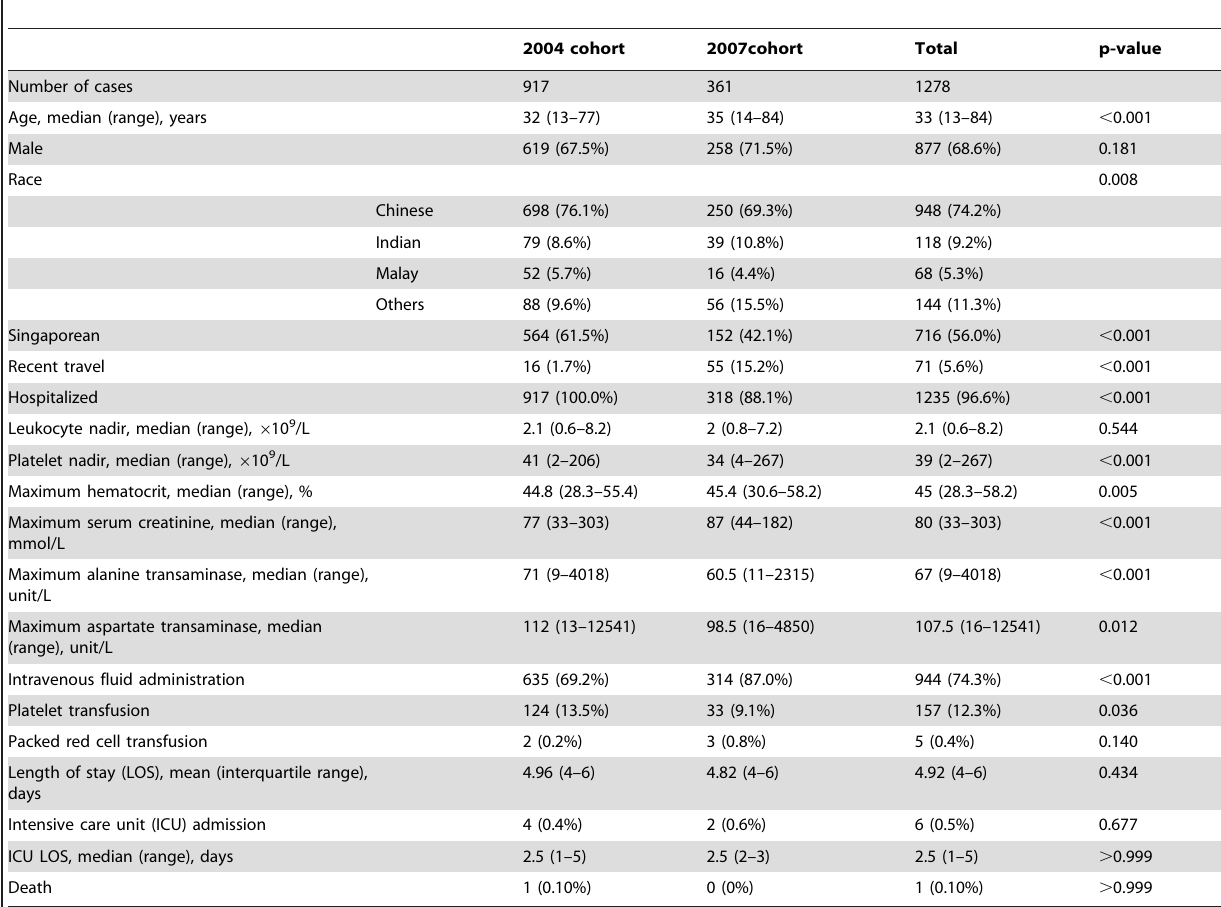
Table 1. Demographic, laboratory, treatment and outcome data of laboratory confirmed adult dengue